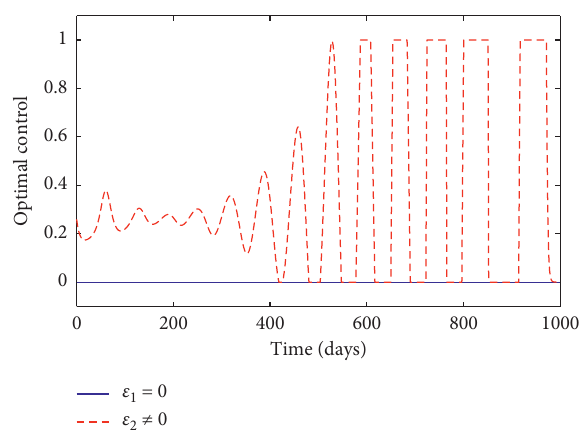
Figure 6: Optimal control strategy with ε